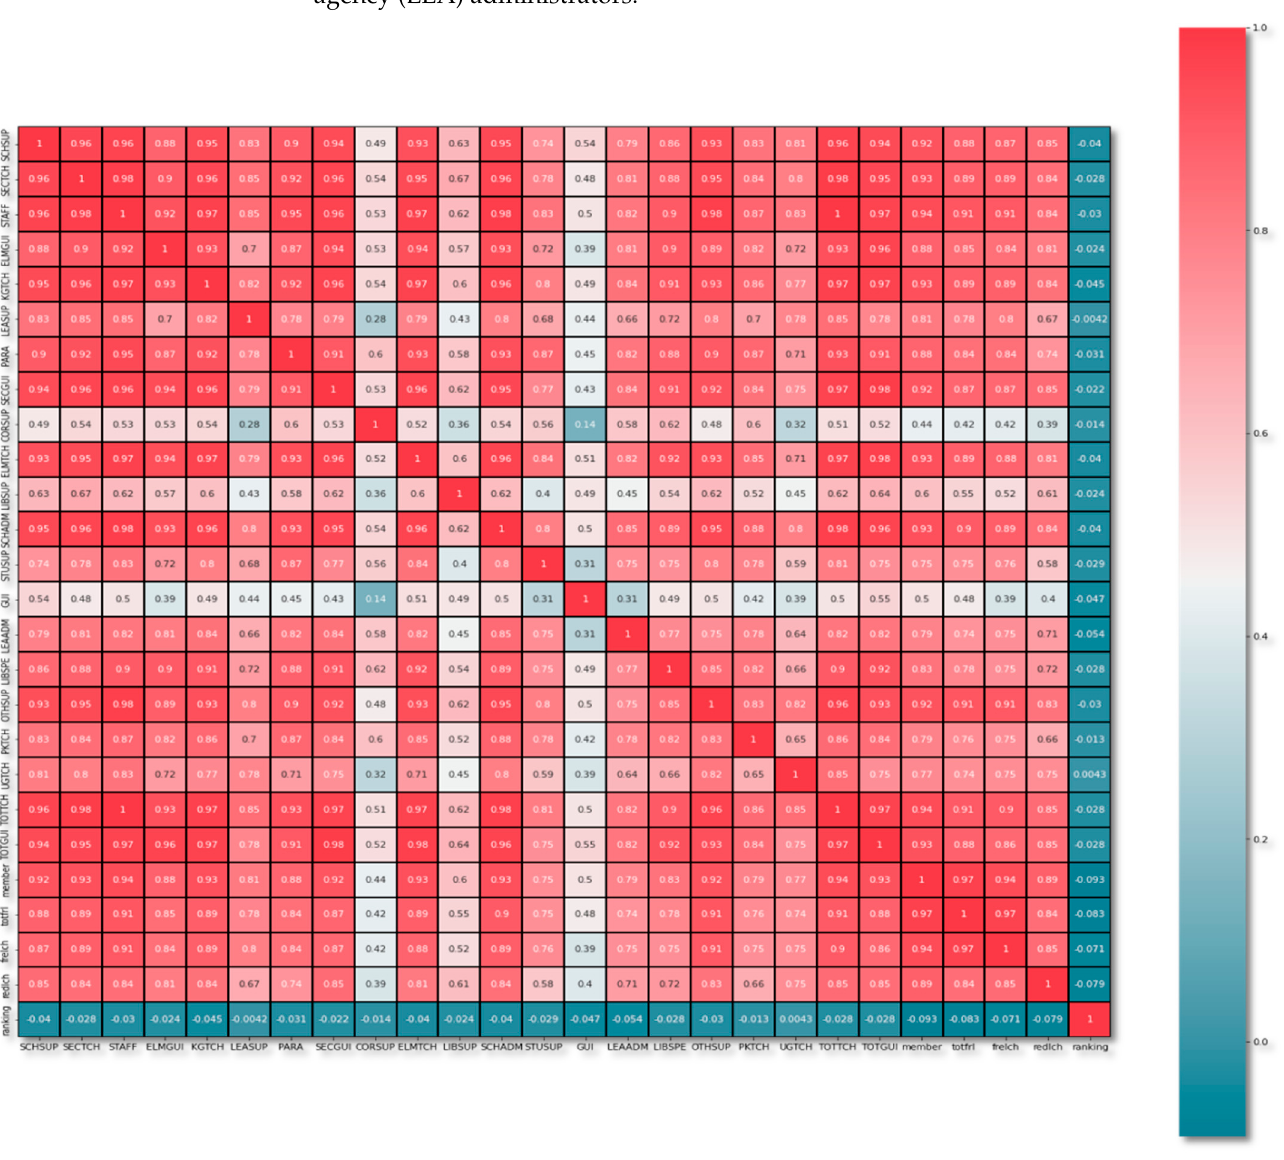
Figure 8. The spatial weighted matrix.